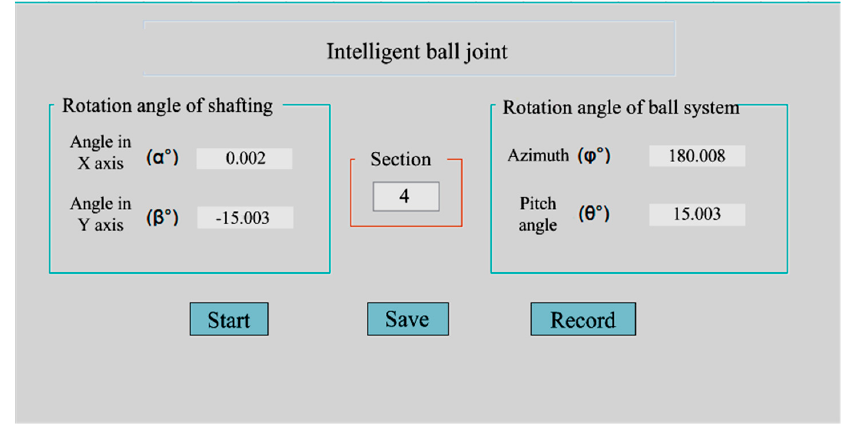
Figure 10. Diagram of PC interface.